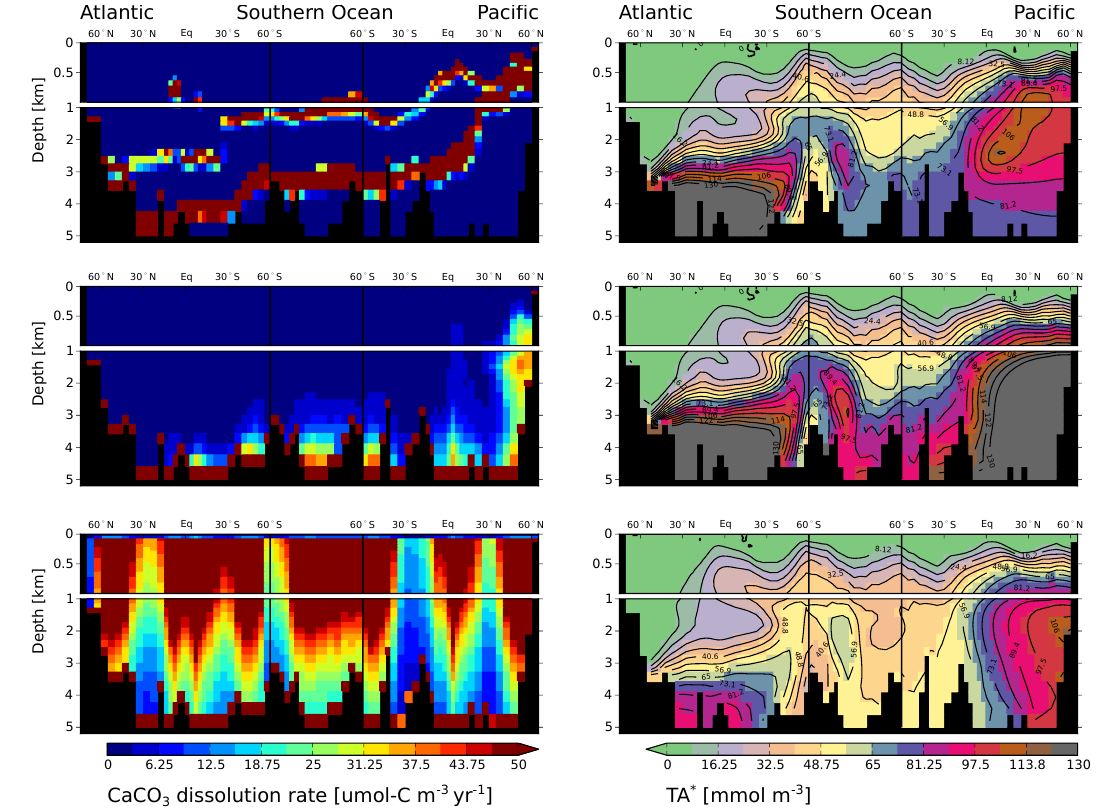
Figure 2. Results from sensitivity simulations applying three different illustrative dissolution schemes. Left column: CaCO 3 dissolution rates. Right column: the resulting steady-state TA ∗ for these three contrasting parameterisations of the CaCO 3 dissolution rate. The dissolution rate is set to increase fast (top row), slowly (middle row) with undersaturation of CaCO 3 , or is set constant throughout the water column (bottom row). The standard version of the Bern3D model without the sediment module is applied, and the fraction of CaCO 3 export in the form of aragonite is set to 10%. At least 43% of the dissolution signal is simulated above the calcite saturation horizon irrespective of whether dissolution is allowed to occur above the saturation horizon (bottom row) or not (middle and top row). This points to the importance of physical transport in shaping the distribution of TA ∗